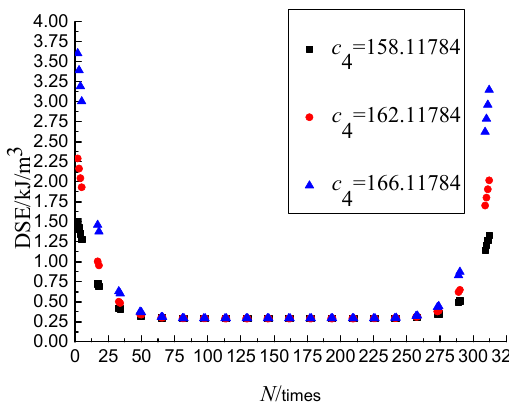
Figure 8. Sensitivity analysis of parameter c 4.